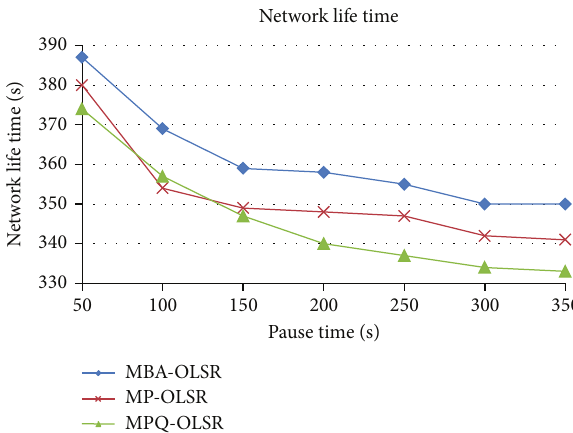
Figure 9: Energy cost per packet for varying pause time.